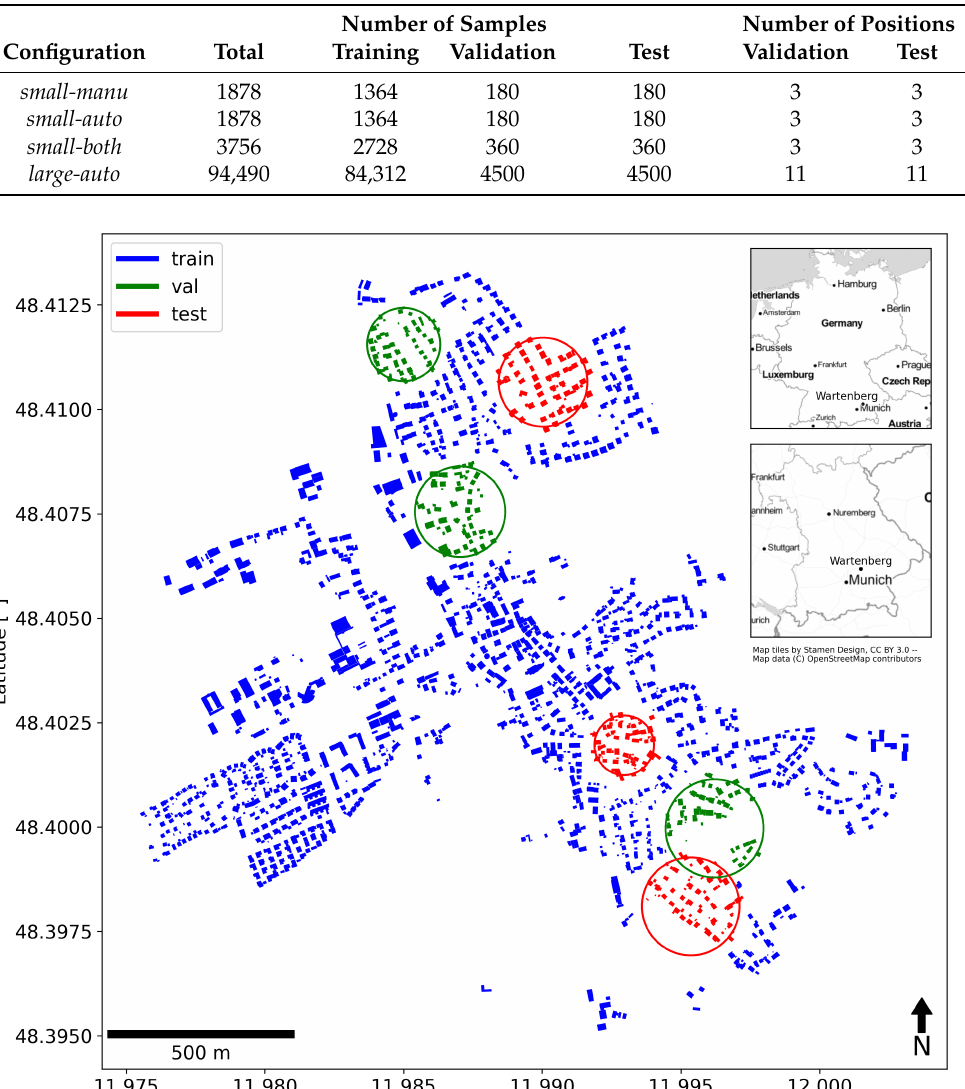
Table 2. Dataset configurations and data splits: numbers of samples in total and in training, valida- tion, and test sets, and number of geographical positions from which validation and test samples were selected.